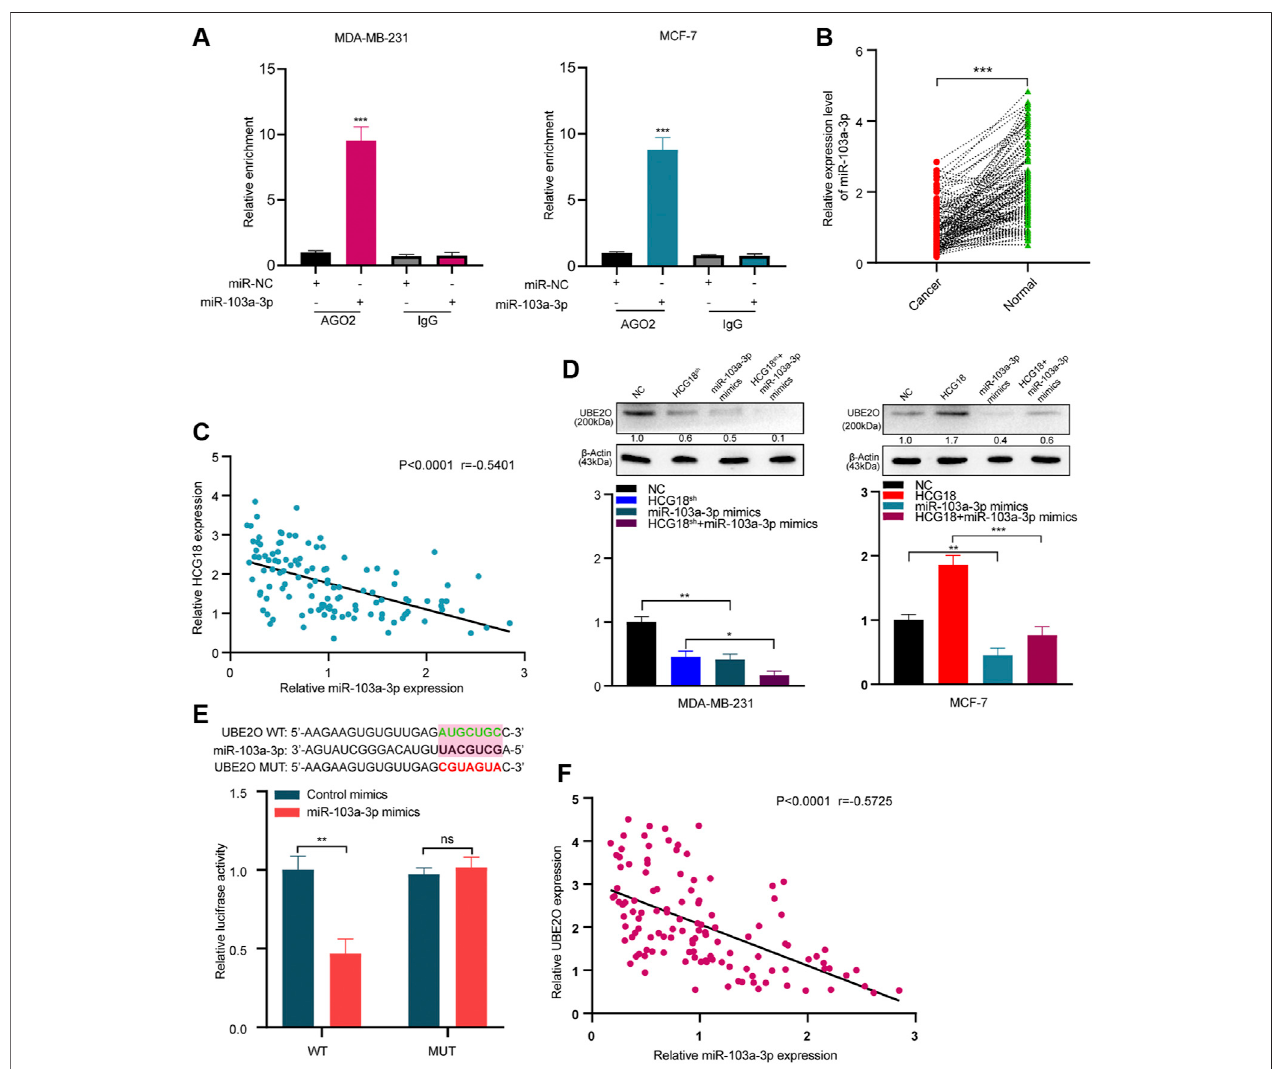
qRT-PCR (B) , and their correlation was determined by Pearson correlation analysis (C) . (D) miR-103a-3p mimics were transfected into MDA-MB-231 NC /MDA-MB- 231 HCG18-sh and MCF-7 NC /MCF-7 HCG18 cells, and thenqRT-PCRand Western blottingassayswereperformedtodetect thechangesinUBE2Oexpression inthe indicated cells. (E) UBE2O-WT/UBE2O-Mut and miR-103a-3p mimics were cotransfected into HEK-293T cells, and then dual-luciferase reporter assays were performed. (F) Pearson correlation coef fi cient was employed to analyze the relationship between miR-103a-3p and UBE2O in BC patients. The data are shown as